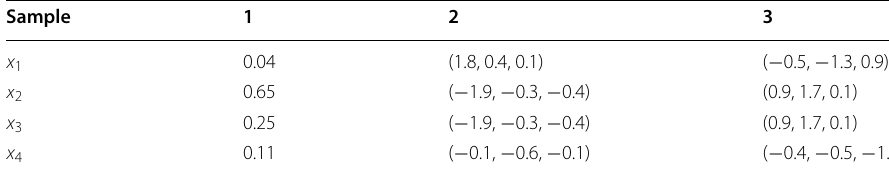
Table 3 The samples according to word embedding method Sample